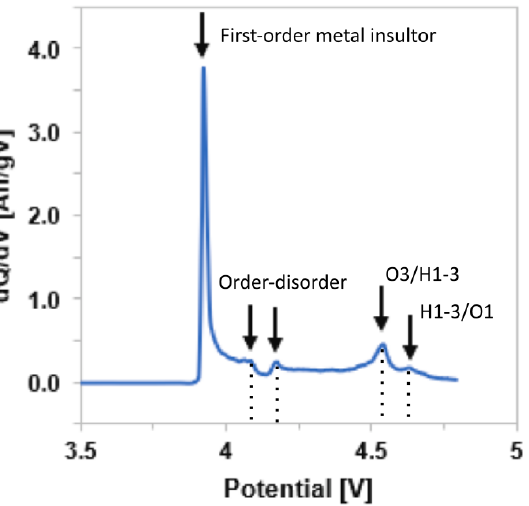
Figure 28. Differential capacity curve of a fresh LCO half-cell charged to 4.8 V at 0.05C. Most relevant phase transitions are highlighted by the black arrows. Adapted with permission by Elsevier from [137], Copyright